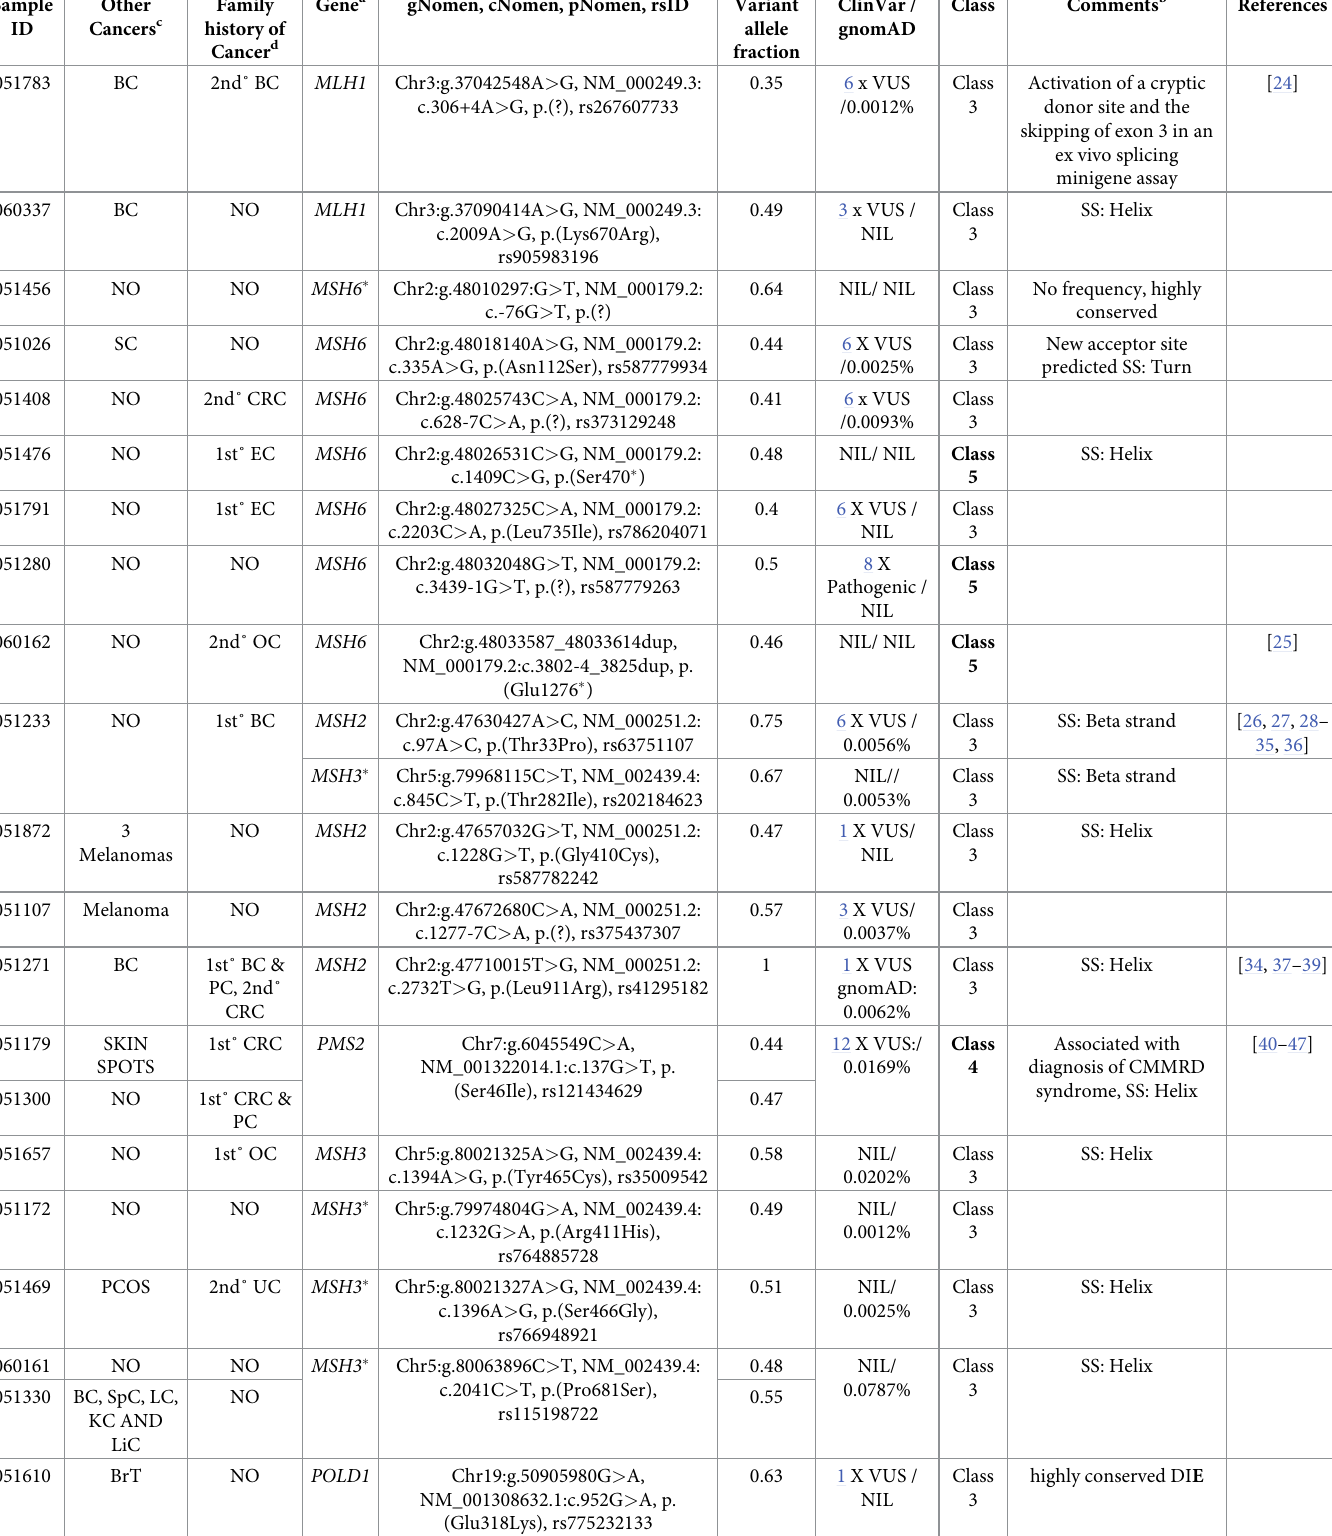
Table 2. Aggregate list of variants and their classification according to the ACMG